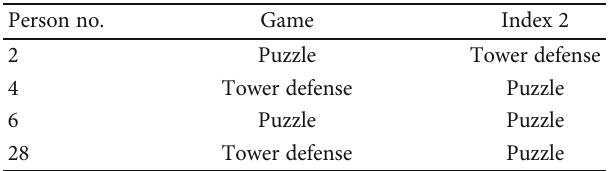
Table 11: Comparison of games that were indicated by the respondent and by index 2.